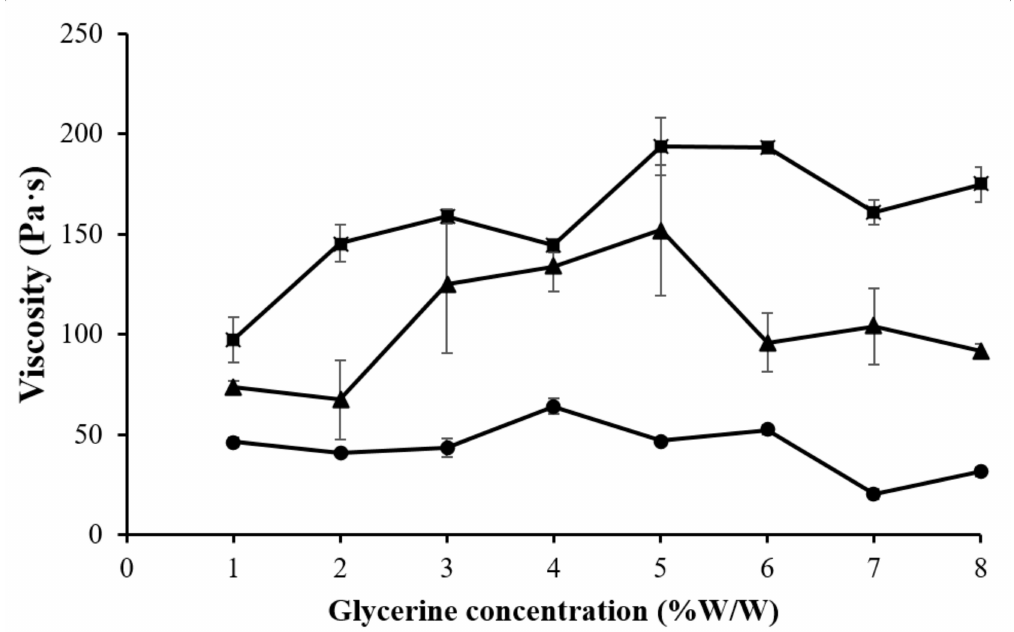
Figure 6. Viscosity of the gels prepared from ( (cid:4) ) 4% carboxymethyl cellulose (CMC), ( • ) 5% low molecular weight chitosan (LMCS), and ( (cid:78) ) 6.25% high molecular weight chitosan (HMCS) with different glycerin